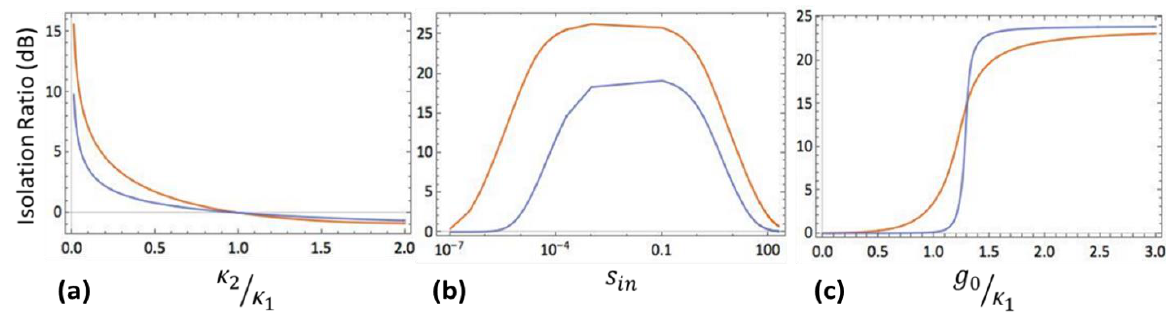
Figure 2. Superior asymmetric light transmission performance of the system as a function of ( a ) the coupling strength  2 (with ( 𝑆 ≡ 𝑆 orange line and ( 𝑆 = 2 , 𝑔 = 2 ) for the blue line); ( b ) the input signal power (with ⁄ = 0.0001 , 𝑔 = 1.3 ) for the orange line and (  (   2 1 line); and ( c ) the dropped pump power (with ( 𝑆 = 0.1 ,  ⁄ = 0.004 ) for the blue line). Other parameter: 𝛾 = 0.3 ×  and ( 𝑆 = 0.01 ,   2 1